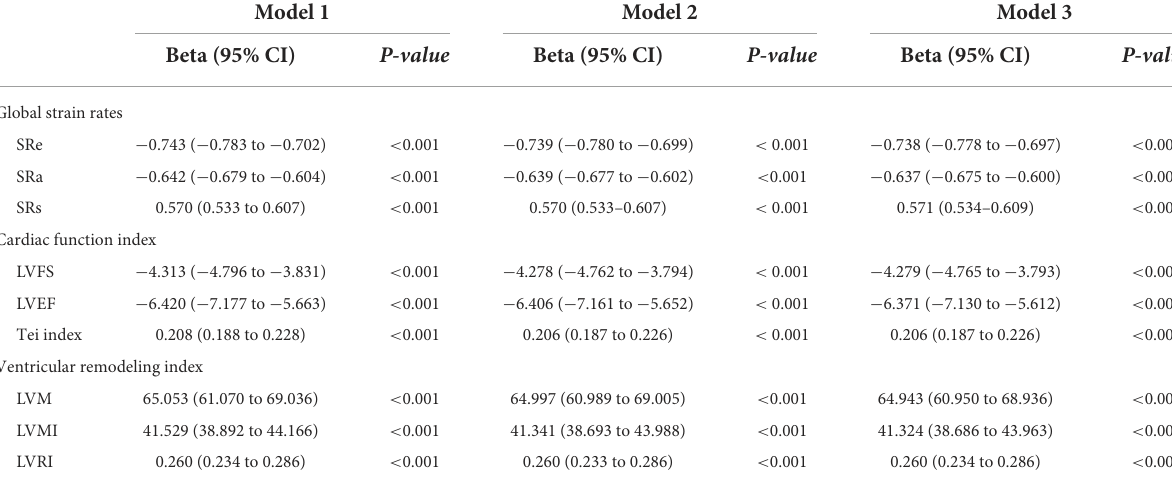
TABLE 4 Association of hsCRP with myocardial strain rates and left ventricular structure and function.